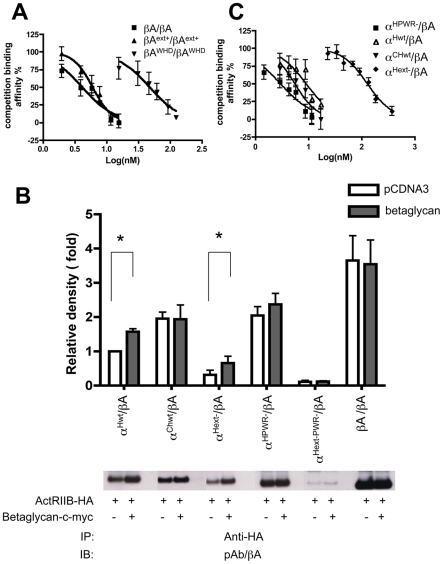
Equilibrium binding of activin and inhibin mutants to ActRIIB using competitive ELISA and immunoprecipitation studies.
A) Conditioned media from βA/βA, βAext+/βAext+, and βAWHD/βAWHD expressing cells were quantified and used to compete with biotinylated activin A for binding to ActRIIB. The IC50 for the βA/βA, βAext+/βAext+ and βAWHD/βAWHD competition binding curves were 4.14±31.61 nM, 5.99±0.98 nM, 47.6±14.3 nM, respectively, representing a significant difference between all groups as determined by sigmoidal dose-response (variable slope) curve, followed by an F-test (p<0.05). The standard curve for biotinylated activin A binding to the ActRIIB (EC50 = 1.1 nM) is shown in Fig. S7A. B) Top, densitometric analysis of immunoblots (bottom) from three independent experiments, Density was normalized to COS7 cells transfected with empty vector (pcDNA3) and treated with human wild type inhibin A. Asterisks represent statistically significant differences using unpaired t-test (p<0.05). Bottom, the immunoblots of the immunoprecipitation that use monoclonal anti-HA pulldown for lysates from COS-7 cells transfected with ActRIIB-HA and either full-length betaglycan or empty vector (pcDNA3). Prior to cell lysis, the cells were treated with inhibin deletion mutants, wild type human inhibin A, chicken inhibin A or activin A culture media for 2 hours. The western-blots are detected by anti-βA-subunit polyclonal antibody. Controls for the immunoprecipitation studies are shown in Fig. S8. C) Conditioned media from αHwt/βA, αCHwt/βA, αHext−/βA and αHwr−/βA expressing cells were quantified and used to compete with biotinylated inhibin A for binding to ActRIIB. The IC50 for the αHwt/βA, αCHwt/βA, αHwr−/βA and αHext−/βA competition binding curves were 9.01±3.72 nM, 5.55±1.85 nM, 2.96±1.23 nM and 127.9±17.80 nM, respectively, representing a significant difference between all groups as determined by sigmoidal dose-response (variable slope) curve, followed by F-test (P<0.05). The standard curve for biotinylated inhibin A binding to the ActRIIB (EC50 = 2.73 nM) is shown in Fig. S7B. The graphs shown in (A) and (C) represent the results of more than three independent experiments.